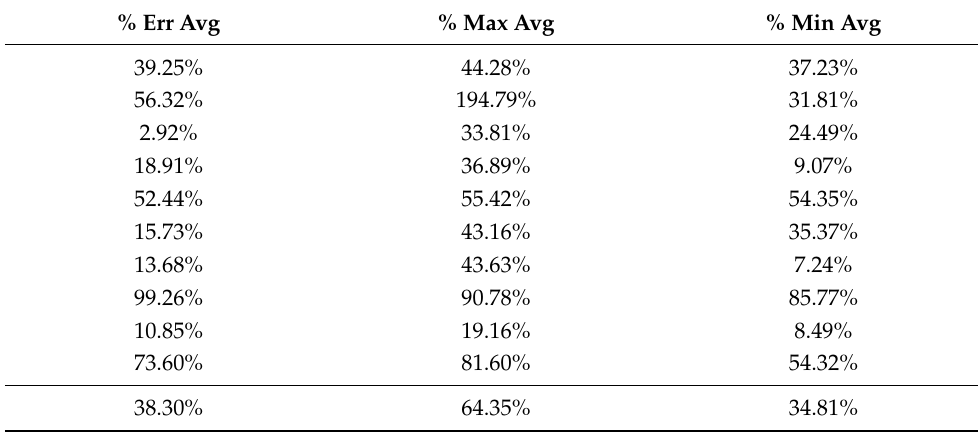
Table A58. Set 1, trials 31–40 data (average actual PR values).